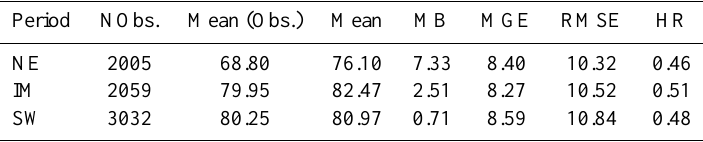
Table 5. Same as Table 4 but for relative humidity.